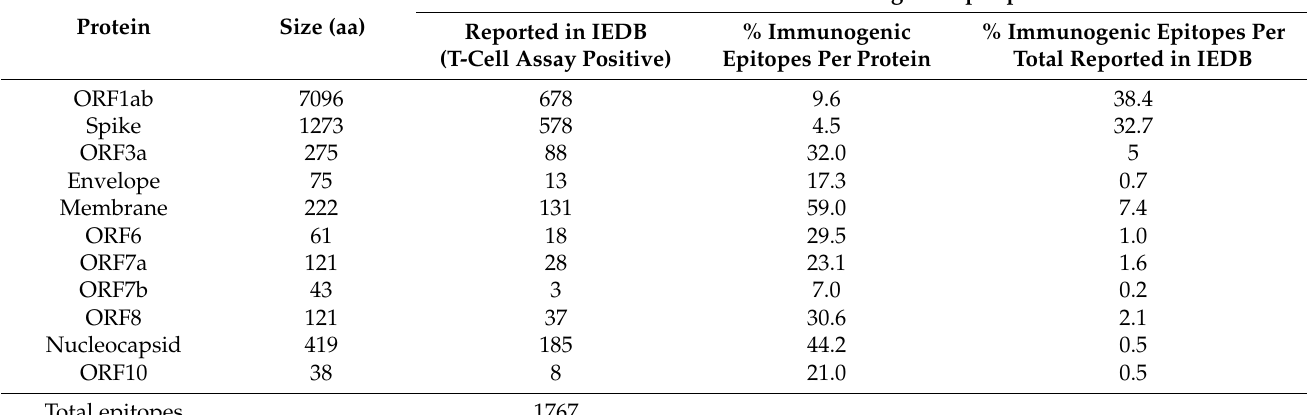
Table 2. The number of SARS-CoV-2 immunogenic epitopes (T-cell assay positive) as reported in IEDB. The percentage of immunogenic epitopes over the possible number of 9-mer peptides generated by a protein was calculated. The number in bold indicates the percentage of the immunogenic epitopes over the total number of epitopes. IEDB is accessed on 16 Sept 2021.